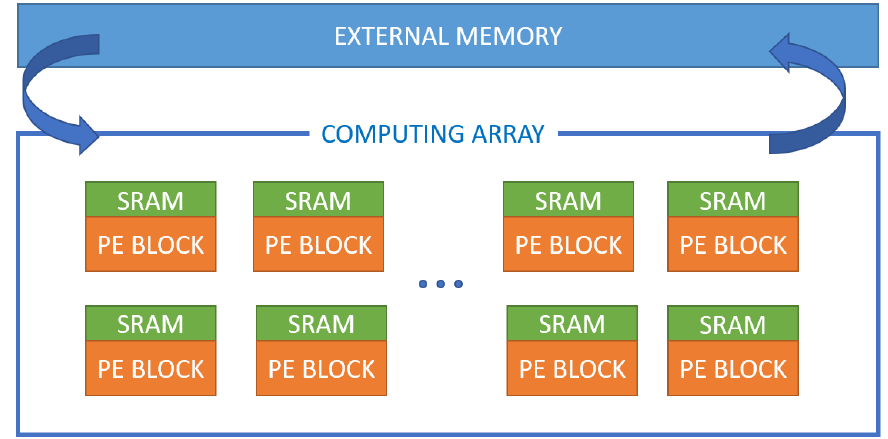
Figure 4. AI SRAM Configuration of PE Array for CNN Computing.